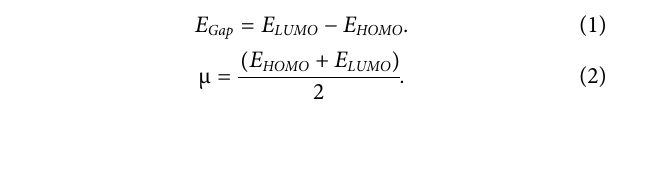
TABLE 1 | A list of some of the electronic features of the fi rst six structures of Sila- fullerane (in unit eV). Nanoparticle HOMO LUMO E